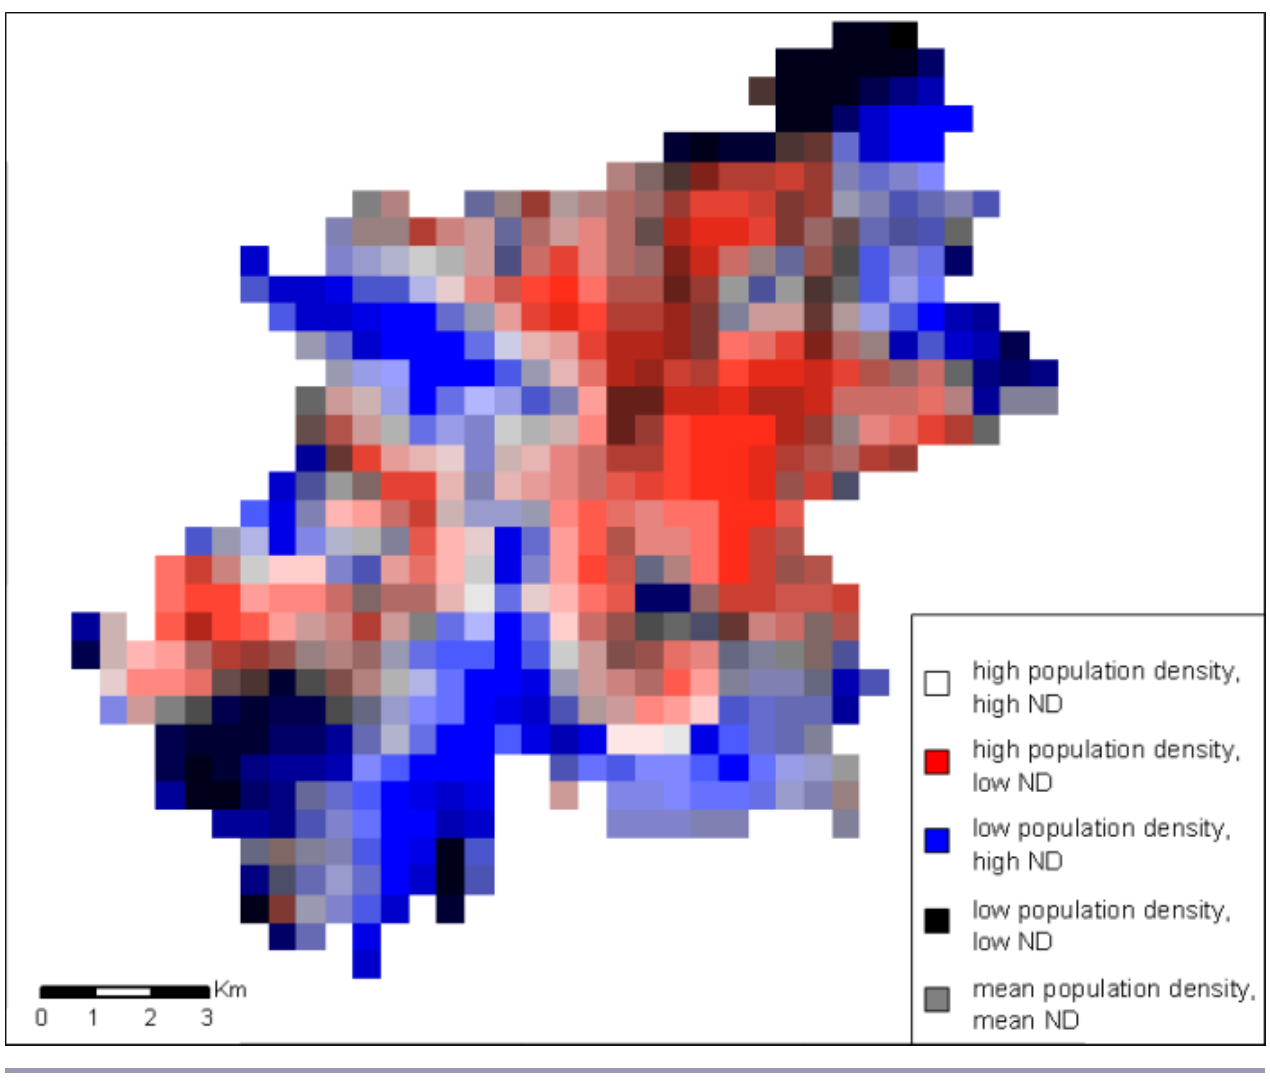
Fig. 2. The distribution of human population and breeding bird diversity in Leipzig, Germany. ND = neighborhood bird